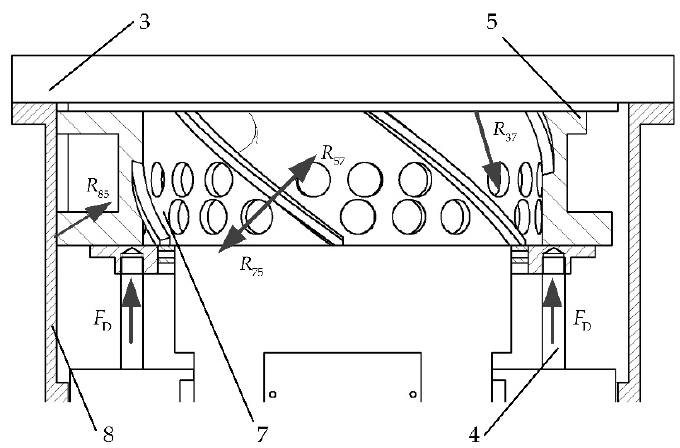
Figure 7. The force analysis of the locking ring sleeve and the locking ring in the holding process. 3—Actuator working cavity, 4—Electromagnet, 5—Locking ring sleeve, 7—Locking ring, 8—Housing.